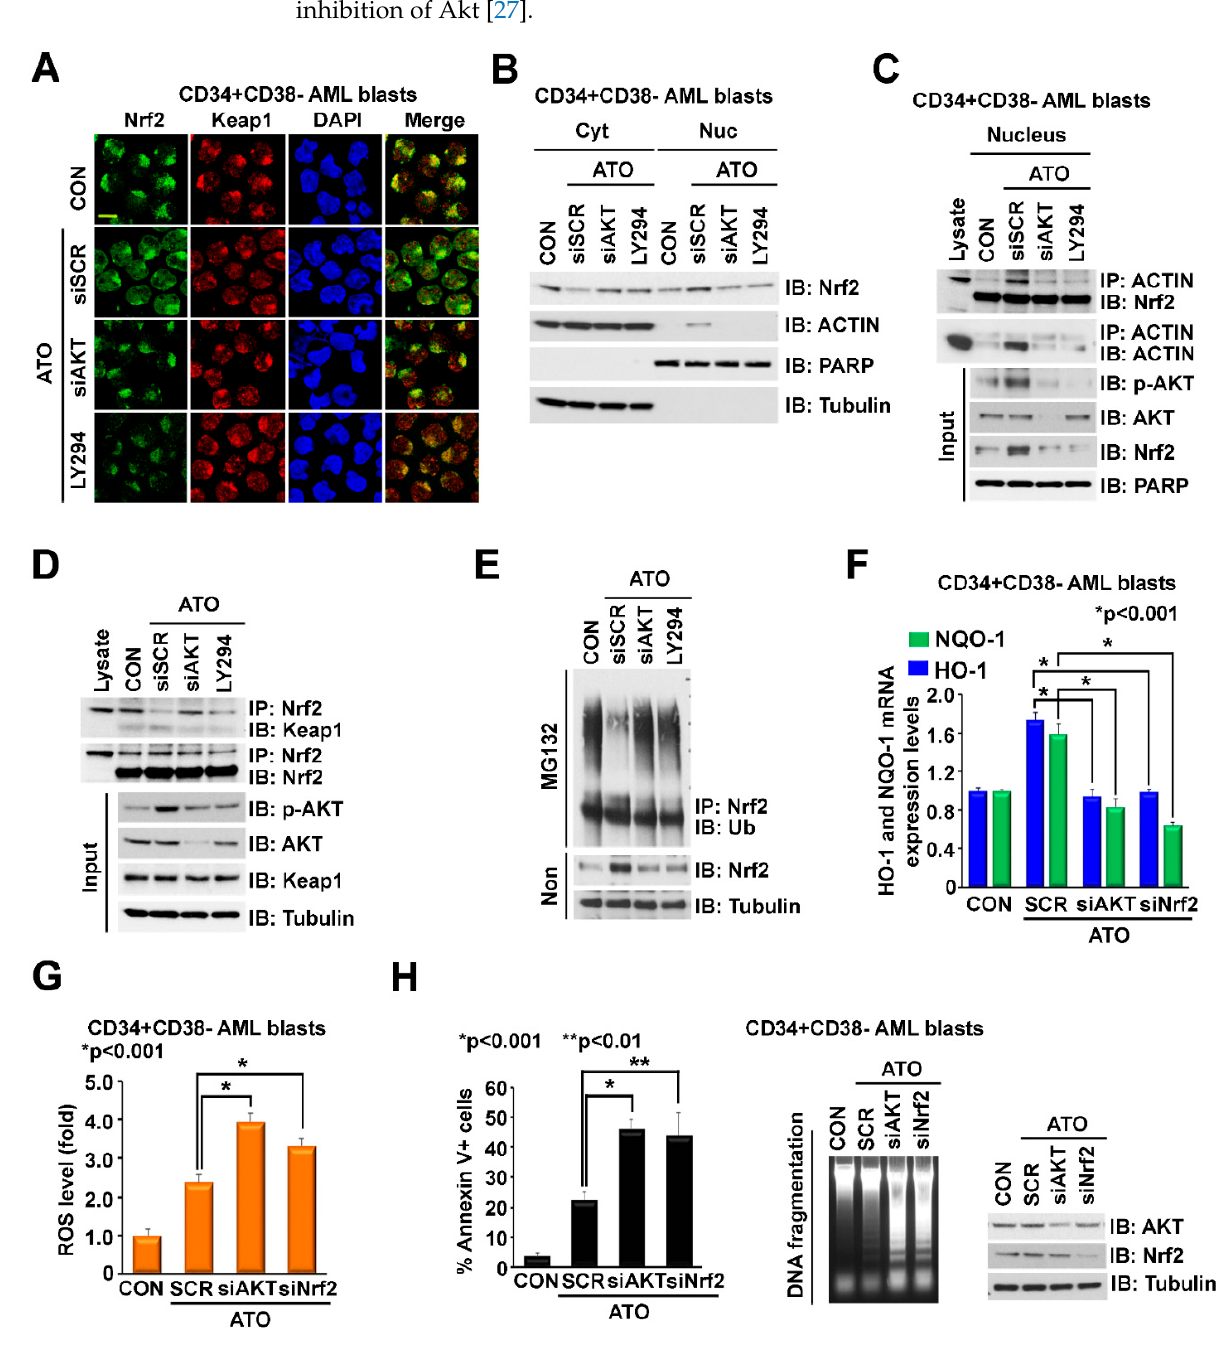
Figure 2. ATO-induced ROS activation is attenuated by concomitant activation of the p-Akt/Nrf2 antioxidant pathway in LSC-enriched AML progenitor cells. ( A , B ) Effects of ATO on cellular distribution of Nrf2 and Actin. LSC-enriched progenitor cells were treated with 500 nM ATO in the presence of siSCR control, siAkt (20 nM), or LY294002 (10 µ M) for 12 h. ( A ) Cells were stained with